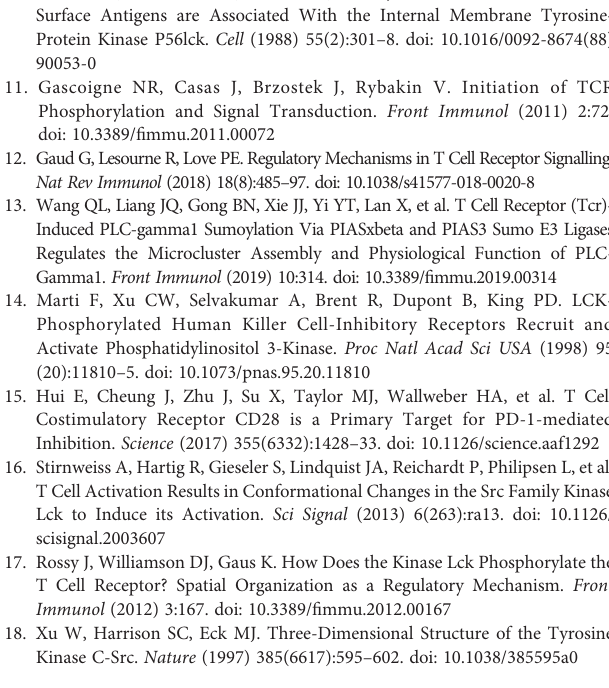
Supplementary Figure 2 | Homemade BbLck polyclonal antibody was attained via rabbit immunization. (A) Prokaryotic BbLck was puri fi ed by CNBr Sepharose. (B) Homemade antisera ef fi cacy and speci fi city were measured via western blot analysis. (C) Homemade antisera speci fi city improved after af fi nity puri fi cation: a, e, i. Flag-vector expressed in HEK293T cells. b, f, j: Flag-BbLck expressed in HEK293T cells. c, g, k: gut tissues were used for endogenous BbLck protein detection. d, h, i: gut cells were used for endogenous BbLck protein detection. (D) The species speci fi city of human Lck antibody (mouse monoclonal) and homemade BbLck rabbit polyclonal antibody. Human Lck antibody or BbLck antibody was used to blot the overexpressed human Lck and BbLck in HEK293T, and to blot the endogenous Lck in Jurkat cells. Supplementary Figure 3 | Association of BbLcLRR with human or amphioxus Lck. The indicated plasmids were cotransfected into HEK293T cells, and cell lysates were immunoprecipitated with anti-Flag antibody followed by immunoblotting with the indicated antibodies. Supplementary Figure 4 | Domain analysis of human SHIP1, SHP1, SHP2, and amphioxus Bb-INPPL1 (Accession No. XP_019617039.1), Bb-PTPN11a (Accession No.